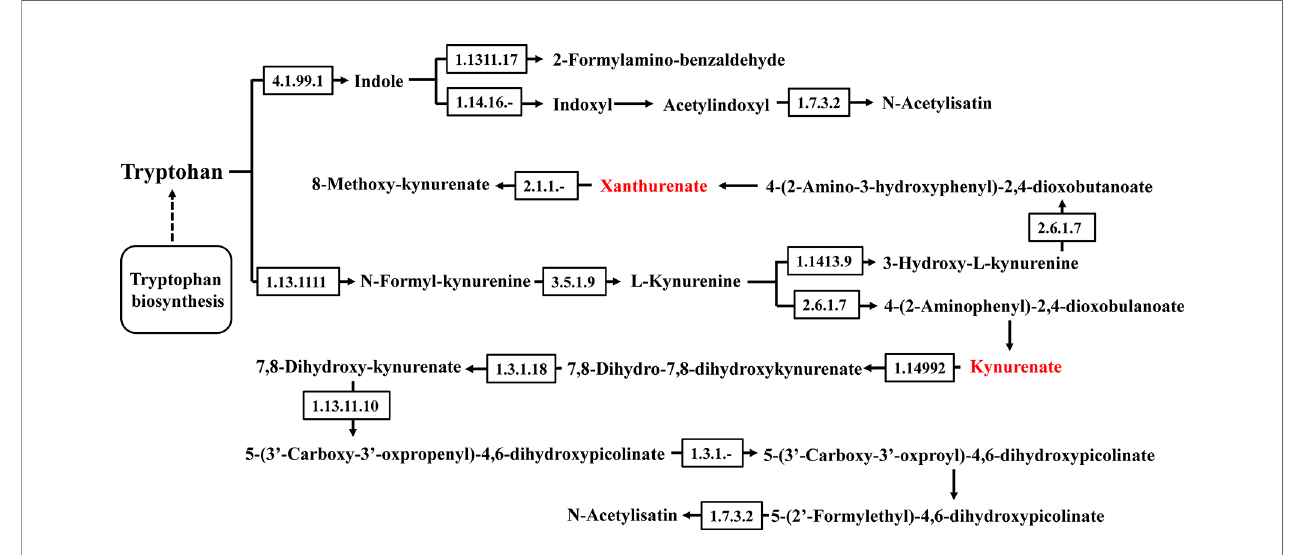
FIGURE 10 | Tryptophan metabolism